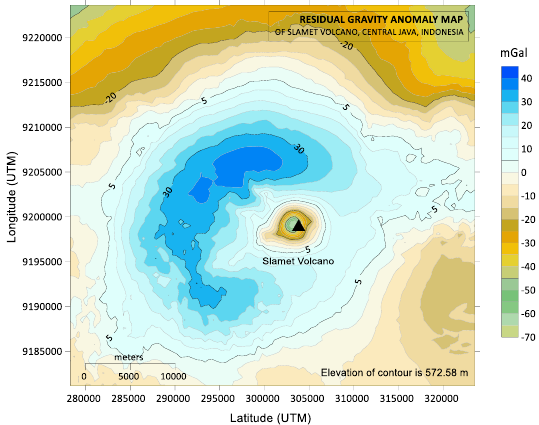
Fig. 8. The residual gravity anomaly contour map of study area